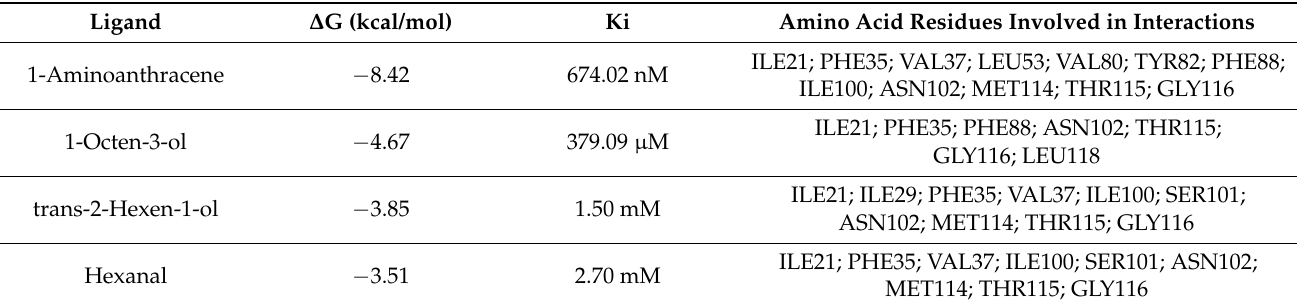
Table 1. Direct docking simulation results. Ligands are arranged in order of decreasing binding affinity